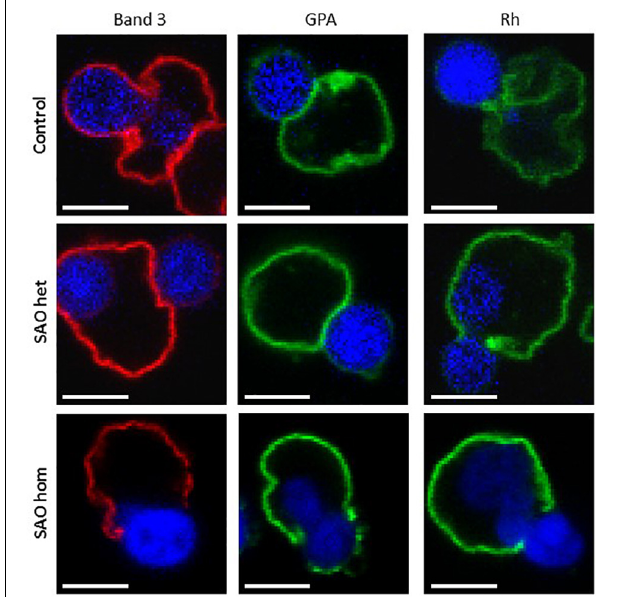
FIGURE 10 | Immunocytochemistry of enucleating cultured CD34 + cells. Late stage control, heterozygous SAO and homozygous SAO cells were fixed, permeabilized and imaged using antibodies directed against band 3 (BRAC17), GPA (BRIC256) and Rh (BRIC69). Images are representative of at least 23 (band 3), 10 (GPA) or 5 (Rh) similar cells observed. Scale bars represent 5 µ m.